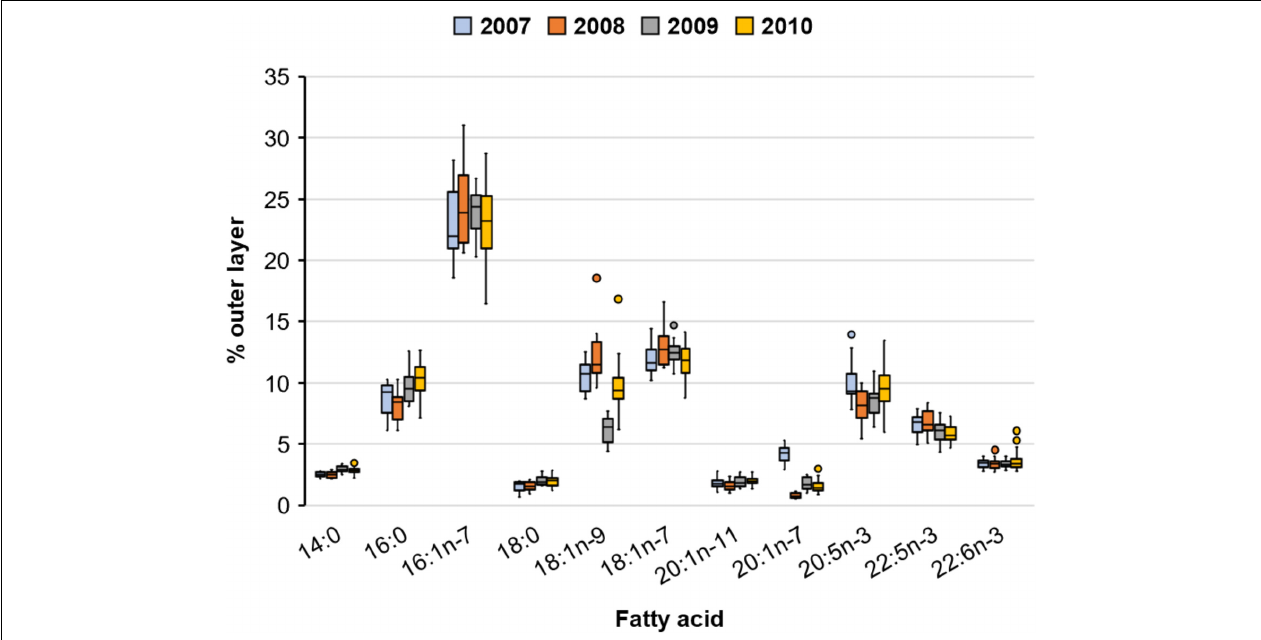
FIGURE 5 | Observed composition in percent abundance of major fatty acids of the outer blubber layer from the sternum of 17, 16, 15, and 52 lactating Pacific walruses in spring 2007–2010, respectively (plots indicate median, 25th and 75th percentile (box), and minimum and maximum (whiskers) excluding outlier points which are beyond 1.5 times the interquartile range).